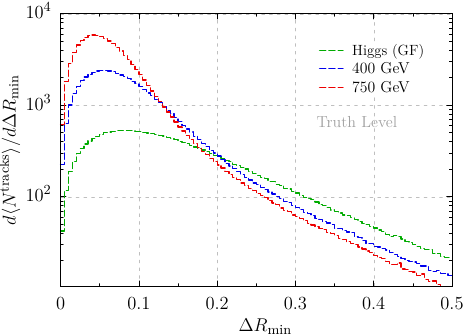
Figure 6. Distribution of minimum (cid:1) R min over all soft bomb tracks with p T > 200